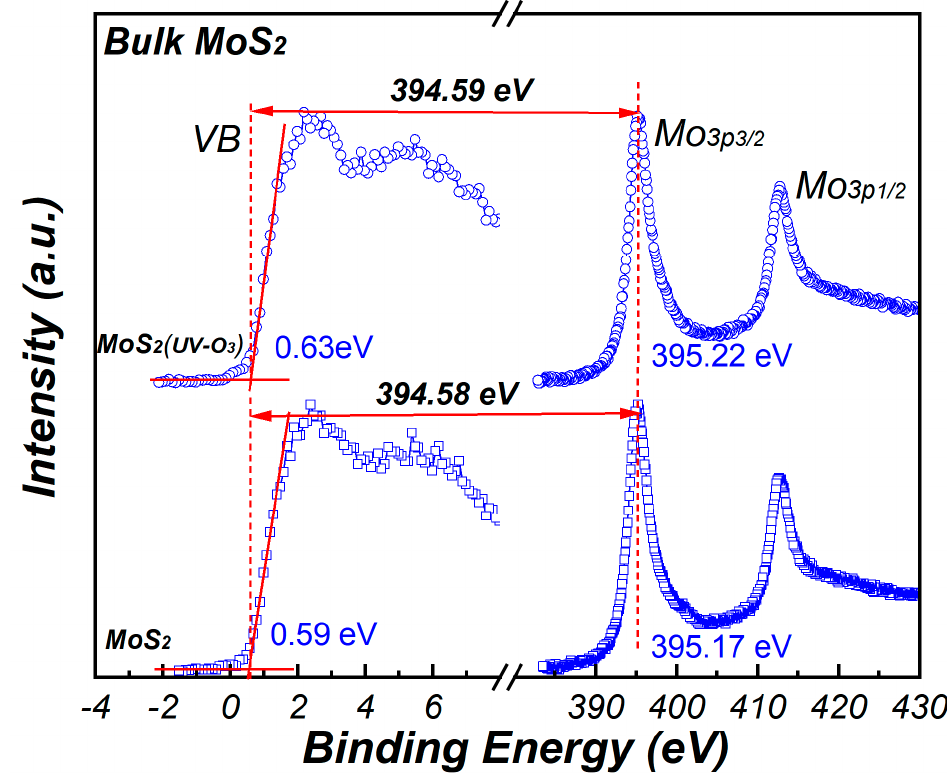
Figure 6. The XPS core level spectra of Mo 3p for MoS 2 . To obtain the conduction band offset (CBO) between La 2 O 3 /Al 2 O 3 nanolaminates and MoS 2 , the optical band gaps of La 2 O 3 /Al 2 O 3 nanolaminates are measured. The optical band gaps form the plots of ( α E ) 2 versus photo energy E are shown in Figure 8. The extrapolation of the linear part of ( α E ) 2 –E down to ( α E ) 2 = 0 gives the values of band gaps [25]. The measured band gap value of O 3 -based and H 2 O-based La 2 O 3 /Al 2 O 3 nanolaminates is 6.37 eV and 6.19 eV, respectively. These values are in good agreement with the reported values of La 2 O 3 /Al 2 O 3 gate stack or LaAlO 3 films ranging from 6.1–6.4 eV [17,26]. The results indicate that the O 3 -based La 2 O 3 /Al 2 O 3 nanolaminates has a lager bandgap value compared to the H 2 O-based nanolaminates. This may be caused by the lower content of impurities found in O 3 -based La 2 O 3 /Al 2 O 3 nanolaminates compared to H 2 O-based